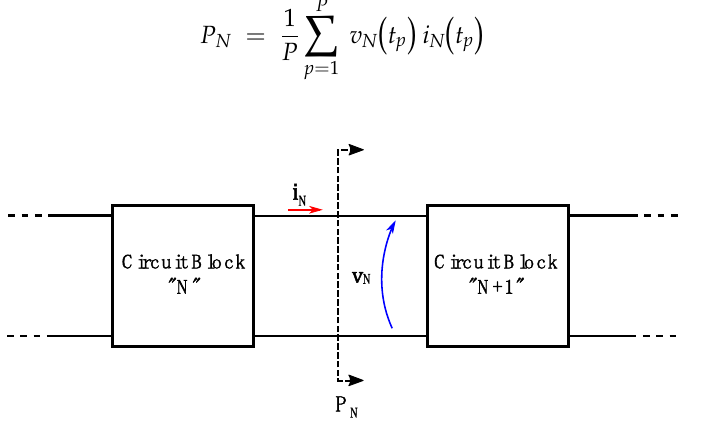
Figure 14. Measurement of power 𝑃 (cid:3015) crossing boundary in between two consecutive circuit blocks.